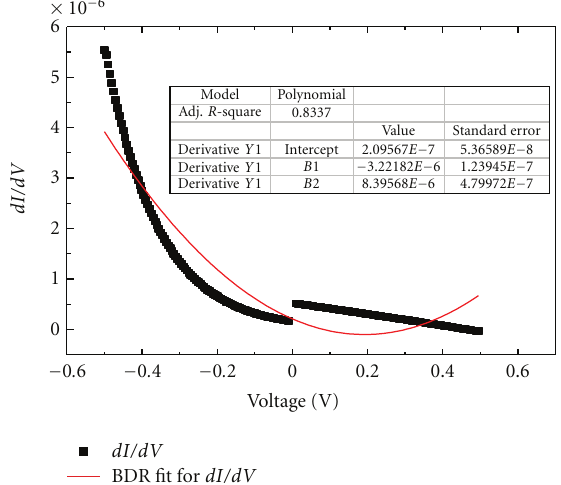
Figure 6: dI/dV of Ti-TiO 2 (plasma)-Pt MIM diode with fitted